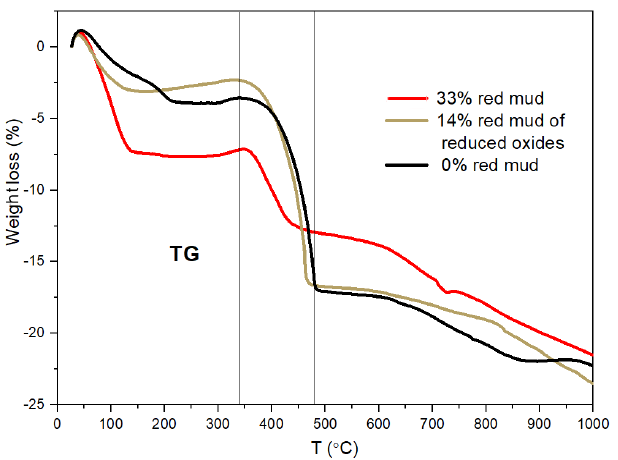
Figure 7. Thermogravimetry measurements of composites vs. red mud content.